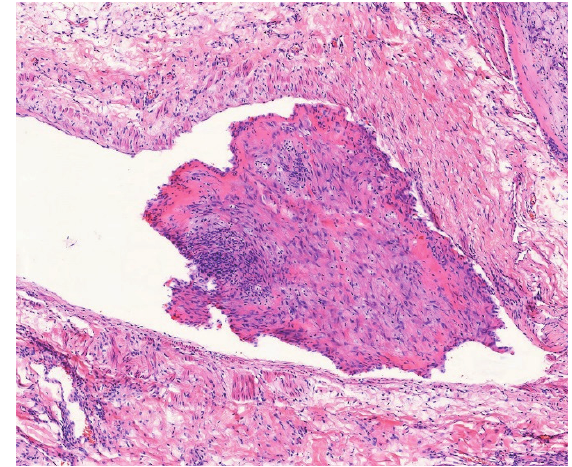
Figure 2 Numerous hyperplastic capillaries were observed in the dilated lumen of the vein; these capillaries were separated by fibrous tissue, forming a lobular structure. (HE stain ×40).